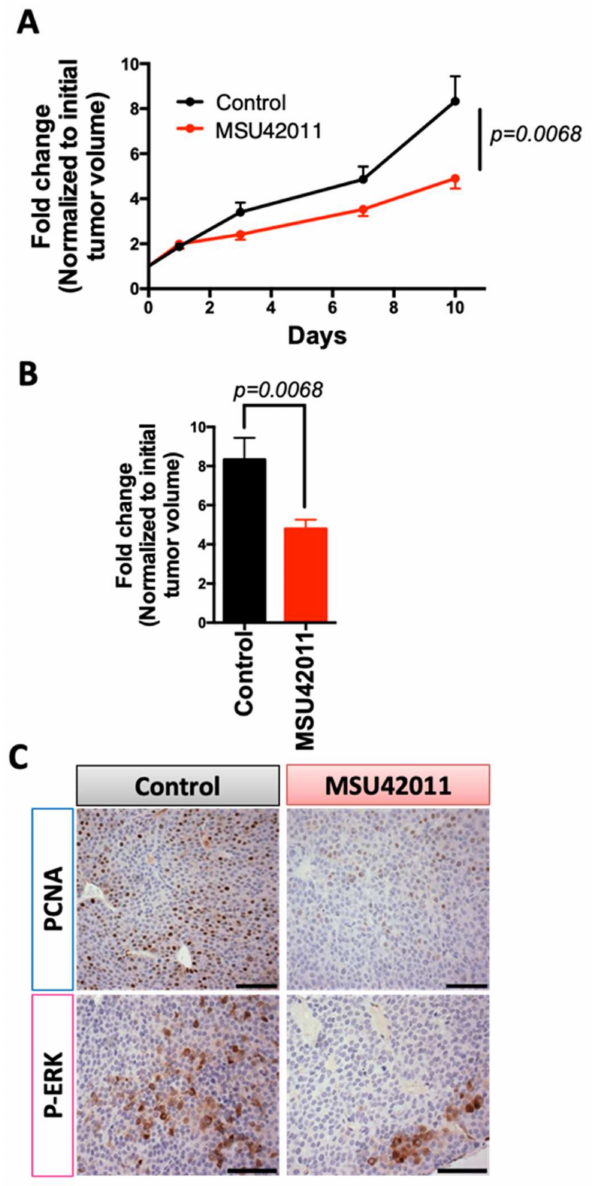
Figure 2. MSU42011 decreases tumor burden in MMTV-Neu mice, a model of HER2-positive breast. MMTV-Neu mice with tumor volumes at least 32 mm 3 in volume were randomized and treated with either control diet or MSU42011 (100 mg/kg diet or ~25 mg/kg body weight) for 10 days ( n = 20/group). ( A ) Fold change in tumor volume over a 10-day period or ( B ) fold change difference on the final day of treatment. ( C ) Cell proliferation in the mammary gland tumors was evaluated by immunostaining for proliferating cell nuclear antigen (PCNA) and p-ERK (scale bar 30 µ m). 3.3. MSU42011 Induced an Anti-Tumor Immune Response in the Tumor